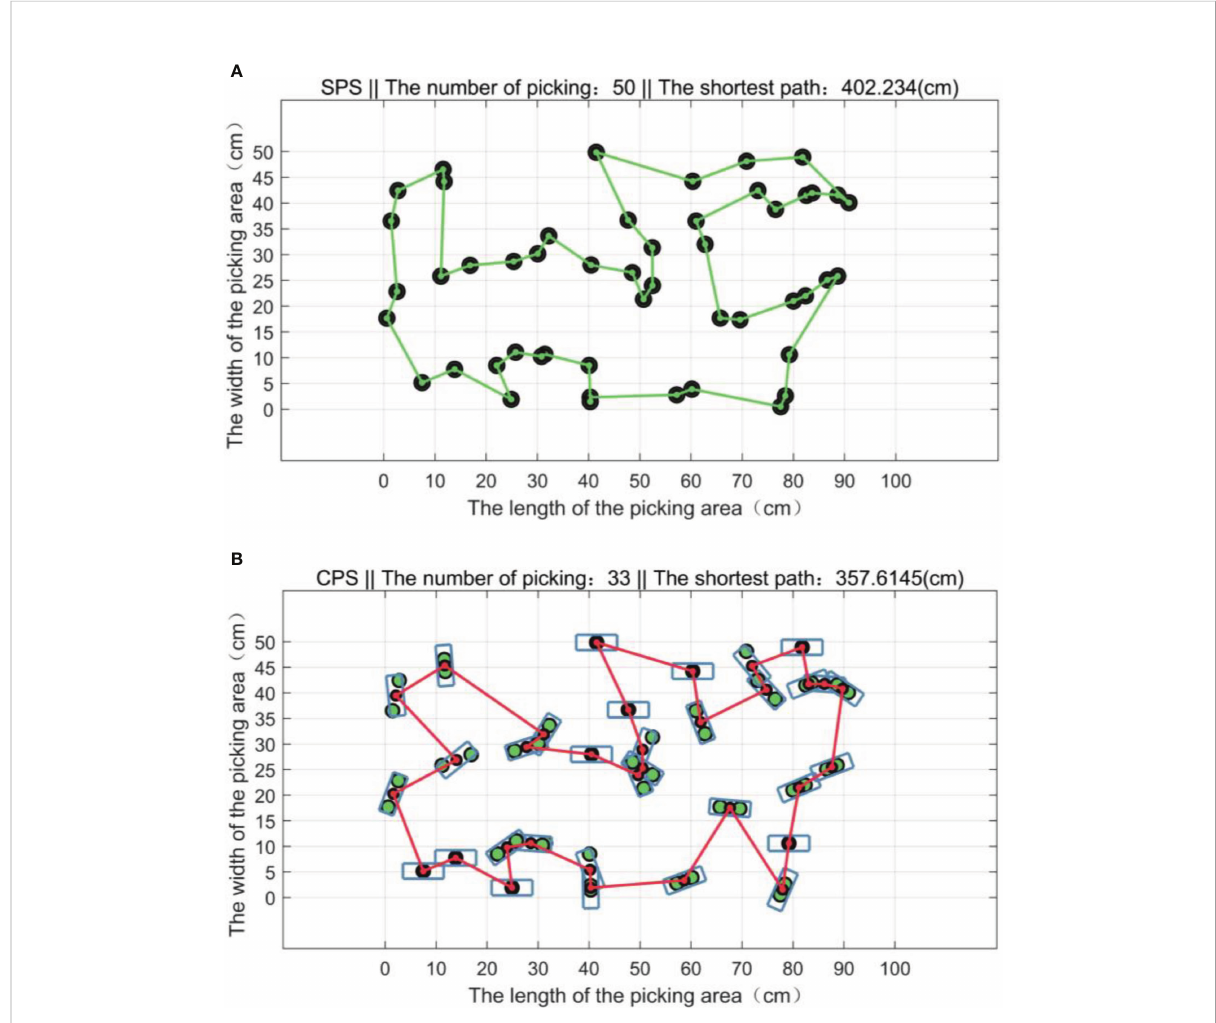
FIGURE 12 The shortest paths of two picking schemes. (A) The shortest paths of the single-point picking scheme (SPS). (B) The shortest paths of the combined multipoint picking scheme (CPS).